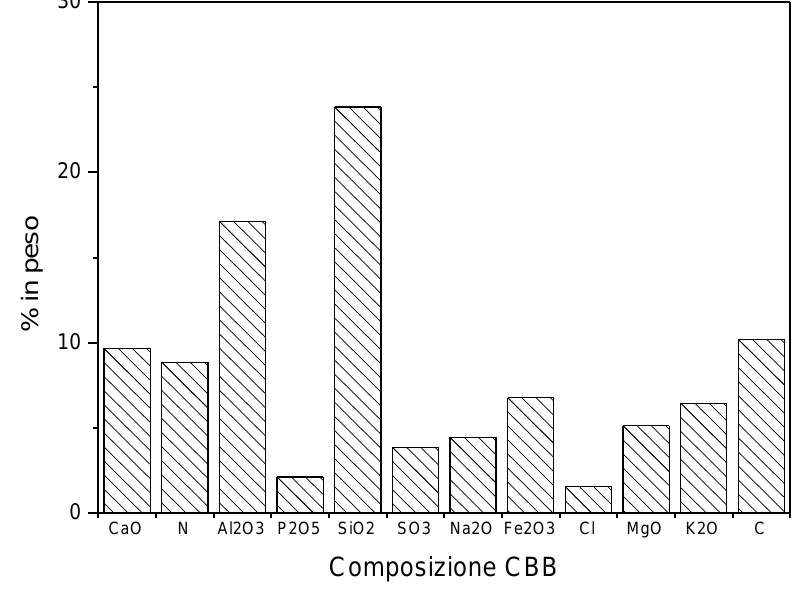
Figure 1. Forest biomass ash (FBA) average composition in terms of oxides.